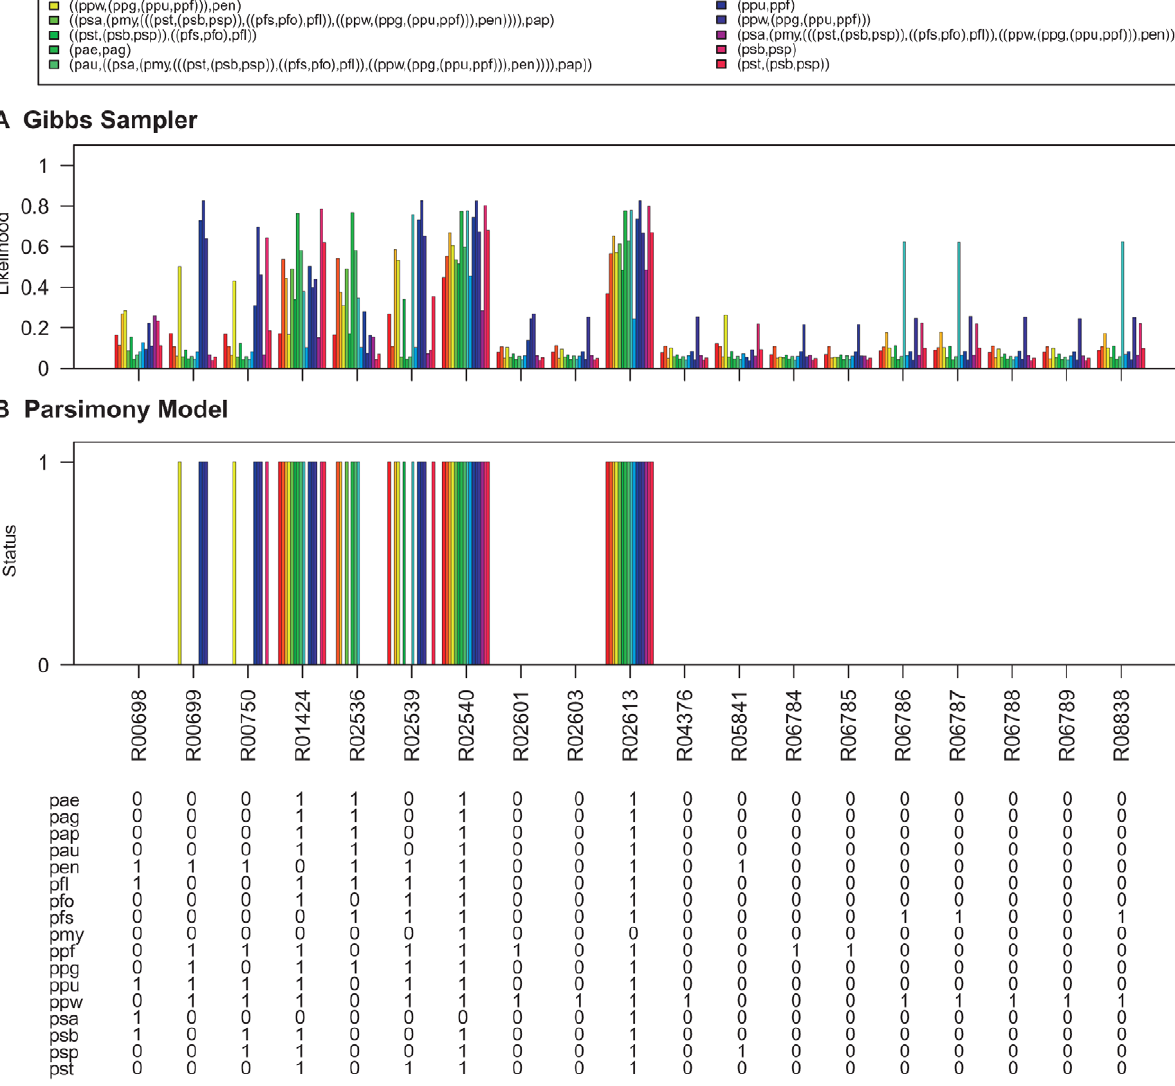
Figure 11. Ancestral network reconstruction for the phenylalanine metabolism map. The ancestral networks were reconstructed over the Pseudomonas phylogeny shown in Figure 6A. Also shown in the bottom panel is the distribution of reactions across different Pseudomonas strains. (A) Likelihood of being present for alterable reactions at various levels of Pseudomonas phylogeny obtained by calculating the proportion of times each hyperedge was present in the networks sampled by the Gibbs sampler. (B) Reaction status obtained under maximum parsimony calculated using the Fitch algorithm [26]. When assigning the reactions at the ancestral nodes the ties were resolved in favor of presence of reactions. Strain abbreviations: pae: P. aeruginosa PAO1, pap: P. aeruginosa PA7, pau: P. aeruginosa PA14, pag: P. aeruginosa LESB58, pen: P. entomophila L48, pfl: P. fluorescens Pf-5, pfo: P. fluorescens Pf0-1, pfs: P. fluorescens SBW25, pmy: P. mendocina ymp, ppf: P. putida F1, ppg: P. putida GB-1 ppu: P. putida KT2440, ppw: P. putida W619, psa: P. stutzeri A1501, psb: P. syringae pv. syringae B728a, psp: P. syringae pv. phaseolicola 1448A, and pst: P. syringae pv. tomato